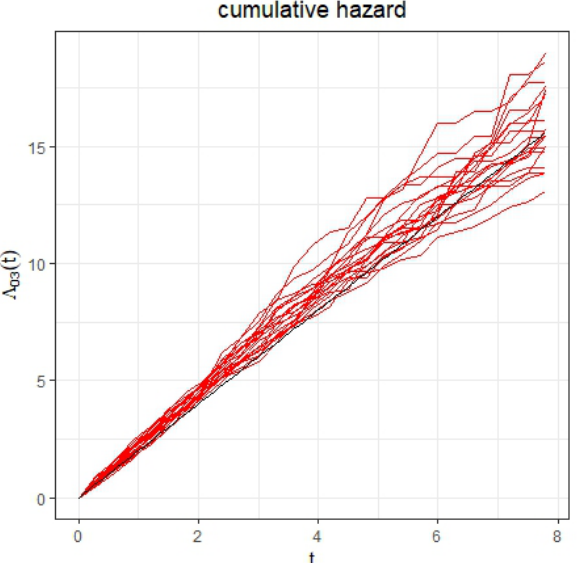
Figure 2. Simulation results for estimated cumulative baseline hazard function Λ 03 ( t ) by the proposed method based on 20 replications (with red color) together with the true cumulative baseline hazard function Λ 03 ( t ) = 2 t (with black color) under the model with gamma frailty in Scenario 1 with sample size